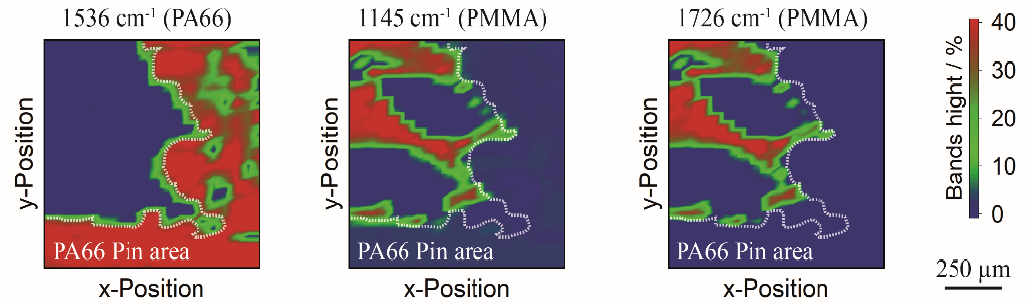
Figure 8. Material detection by FTIR for PA66–PMMA joint at thin cut of the structured ‐ partner (PA66) in the area of the cavity between two pin ‐ like structures.